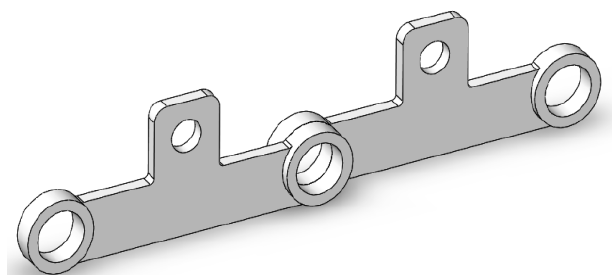
Figure 3. Schematic diagram of vibratory sieving